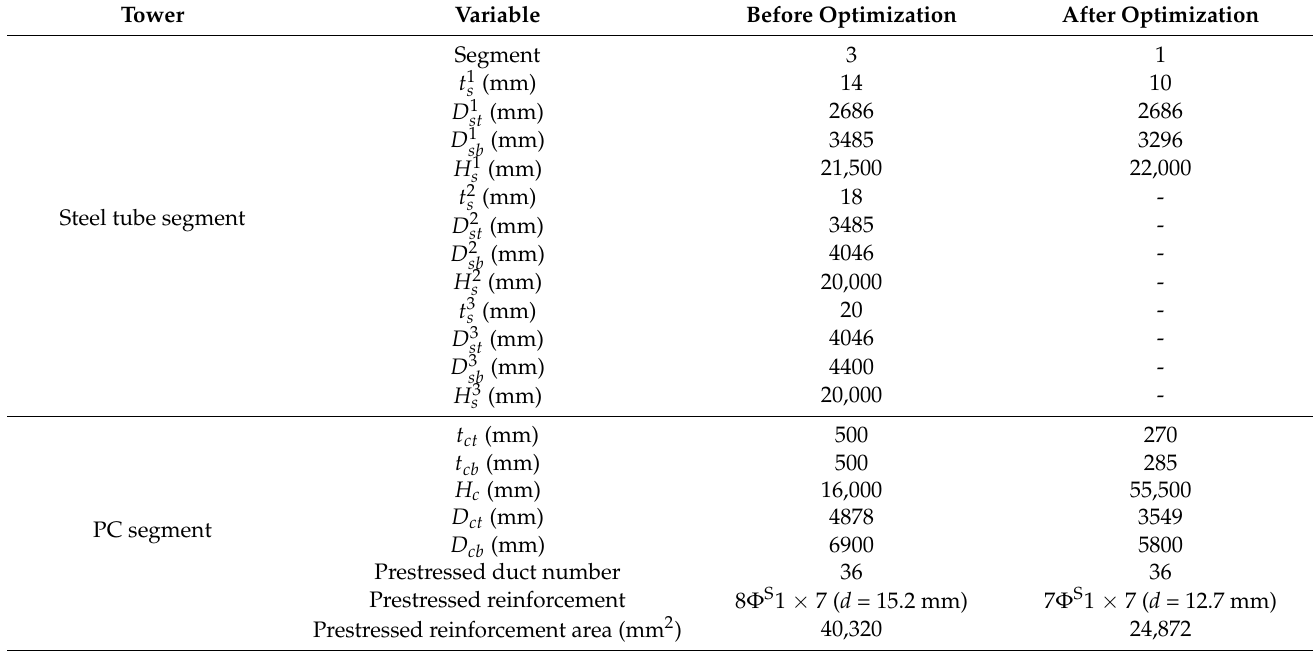
Table 7. PCSH tower dimension before and after